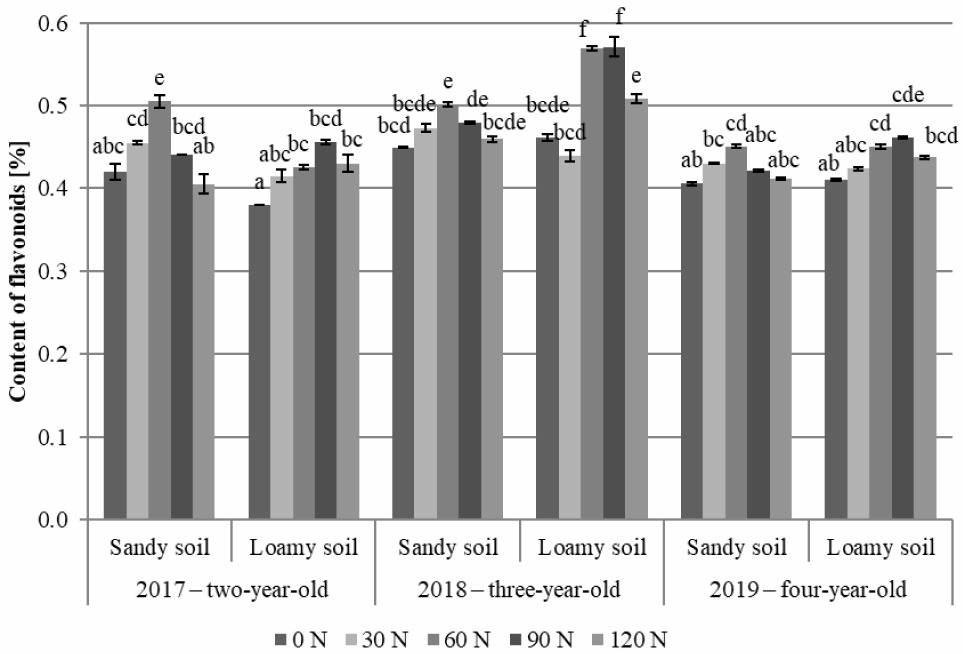
Figure 4. Content of flavonoids in A. chamissonis flower heads depending on the experimental factors; 0 N, 30 N, 60 N, 90 N, 120 N—nitrogen doses (kg · ha − 1 ). Values designated by different letters are significantly different ( p = 0.05) (Tukey test, p <